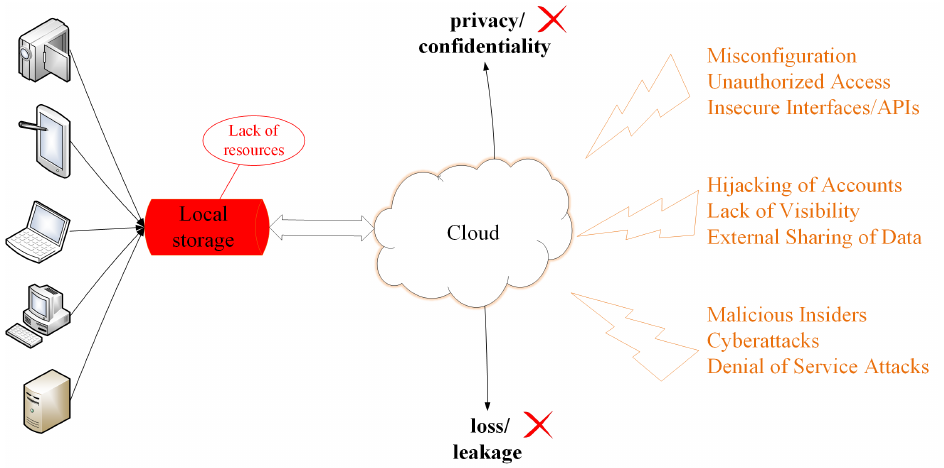
Figure 1. Cloud storage